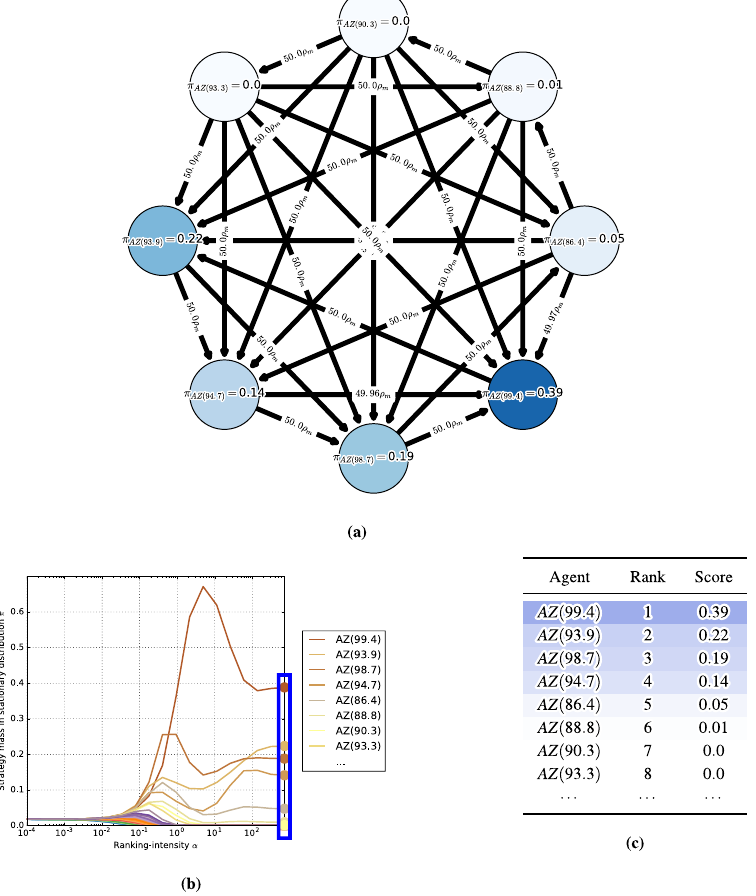
Figure 10. AlphaZero dataset. ( a ) Discrete-time dynamics. ( b ) Ranking-intensity sweep. ( c ) α -Rank